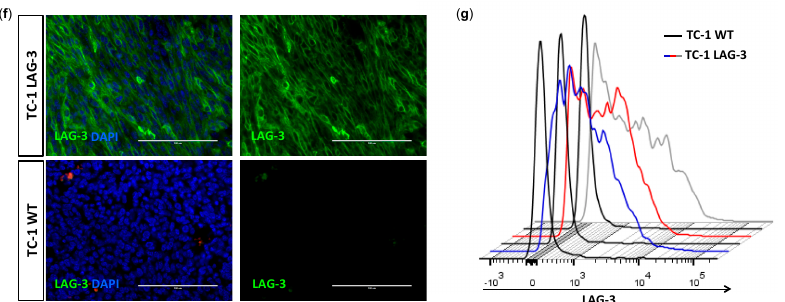
Figure 6. SPECT / CT imaging and biodistribution analysis of 99m Tc-labeled anti-moLAG-3 Nbs in nude mice bearing either TC-1-LAG-3 or TC-1-WT tumors. ( a ) Flow cytometry analysis of the moLAG-3 expression of lentivirally-modified TC-1 cells (red line) or unmodified TC-1 cells (black line). ( b ) Graph showing the tumor growth of TC-1-WT cells (black line) or TC-1-LAG-3 cells (red line). The graph summarizes the data as mean ± SD of 30 mice per condition ( n = 1). ( c ) Ex vivo γ -counting of isolated organs from tumor bearing nude mice 80 min after injection of 99m Tc-labeled Nbs targeting moLAG-3 or control Nb R3B23. The graph summarizes the data obtained in three mice as mean ± SD of uptake, expressed as %IA / g ( n = 1). ( d ) Representative SPECT / CT scans of three TC-1-LAG-3 (right flank) and TC-1-WT (left flank) tumor bearing mice 60 min after injection of 99m Tc-labeled Nb 3132, 3206, or control Nb R3B23 ( n = 1) ( e ) As a measure of image contrast, TC-1-LAG-3 tumor-to-blood, TC-1-LAG-3 tumor-to-muscle, and TC-LAG-3 tumor to TC-1-WT tumor ratios are determined. The graph summarizes the data obtained in three mice as mean ± SD ( n = 1). ( f ) Representative immunofluorescence microscopy of sections from dissected TC-1-LAG-3 tumors and TC-1-WT tumors derived from three mice ( n = 1). moLAG-3 was detected using an anti-moLAG-3 mAb (green). The nuclei of the cells were stained with DAPI (blue). ( g ) Flow cytometry analysis of moLAG-3 expression on single cell preparations of TC-1-LAG-3 (blue, red, and grey lines for Nbs 3132, 3106, and R3B23 respectively) versus TC-1-WT tumors (black lines). The flow histogram graph is representative for three mice ( n =